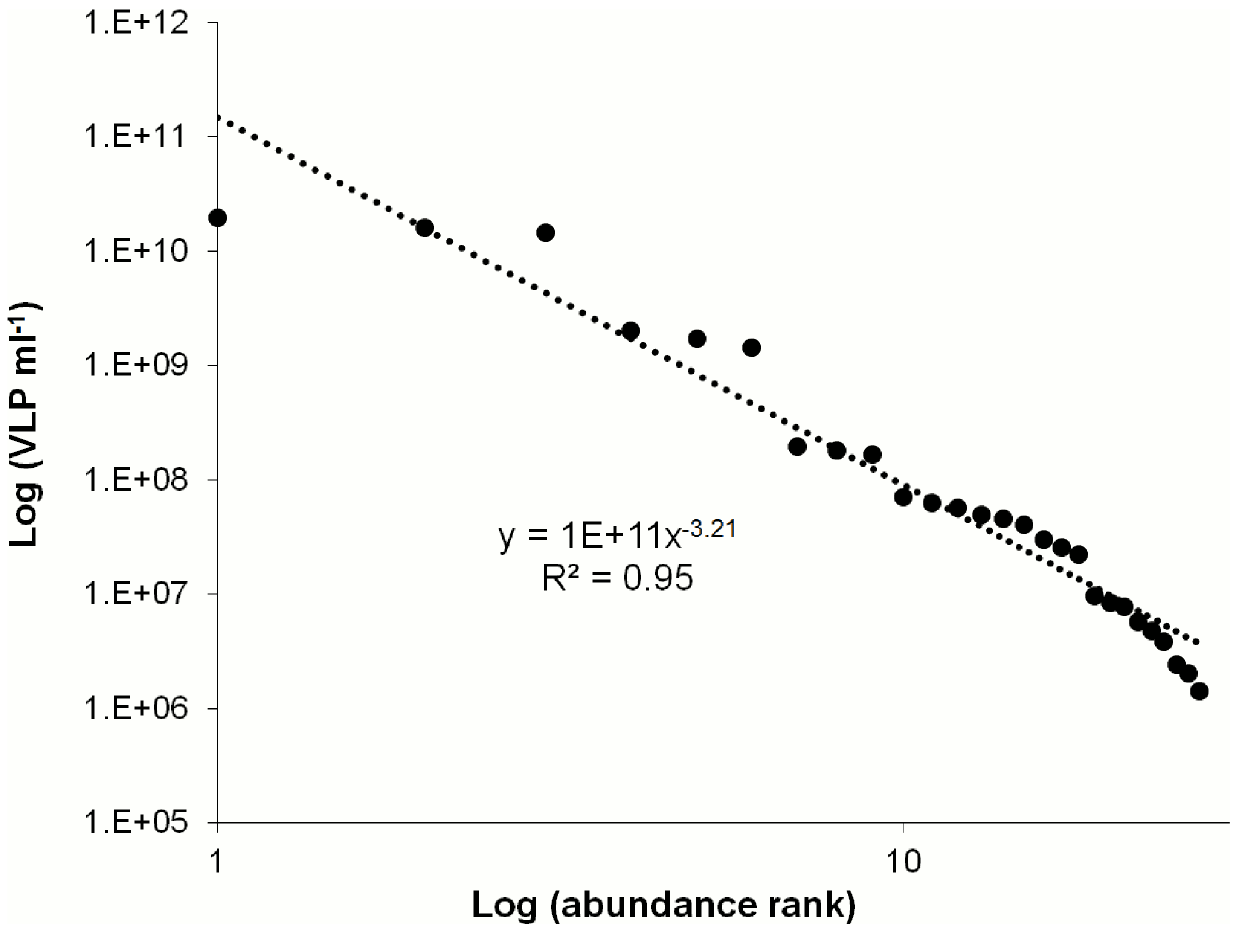
Fig 5. Average VLP rank abundance using all treatment triplicates. Data points follow a power